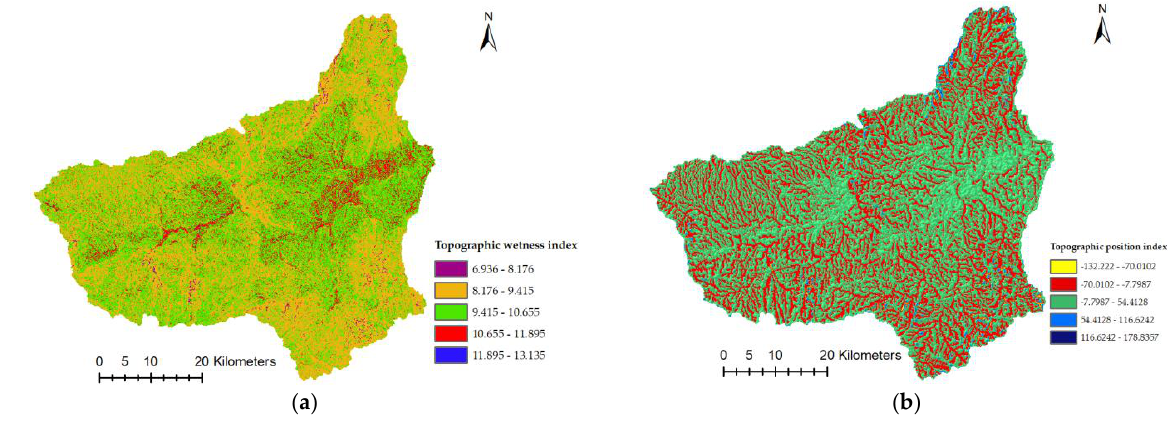
Figure 5. Thematic map of ( a ) Topographic position index, ( b ) Topographic wetness index